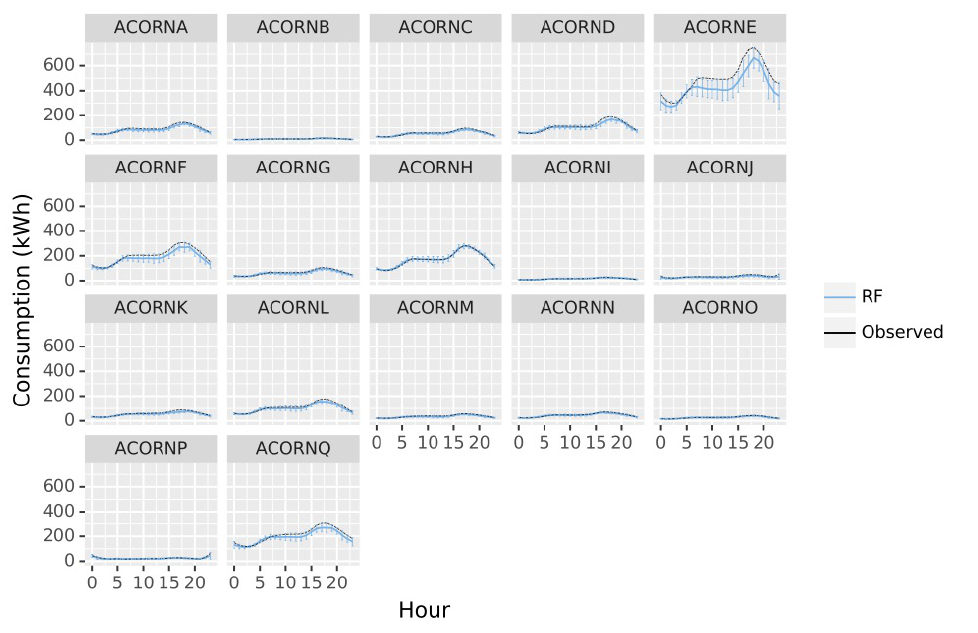
Figure 7. RF mean predictions by hour of the day for each ACORN group across the latest 270 days of data. Error bars represent predictions square